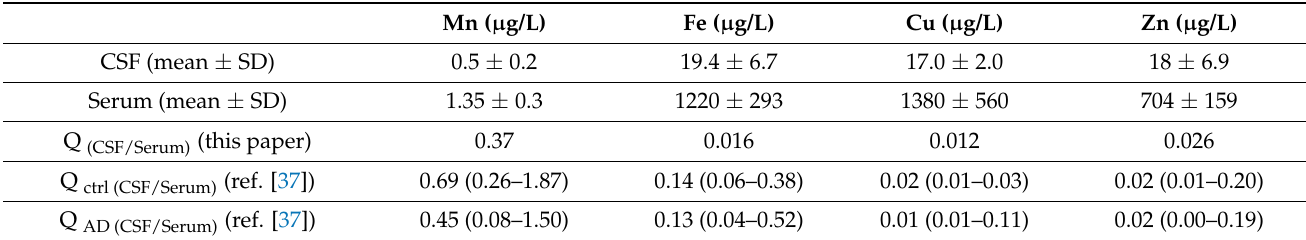
Table 1. Summary of total element concentrations in CSF and serum samples (mean ± SD), ratio of element concentrations. Q (CSF/serum) and comparison with Q (CSF/serum) values from [37]. Q ctrl = ratio from control samples, Q AD = ratio from Alzheimer’s disease